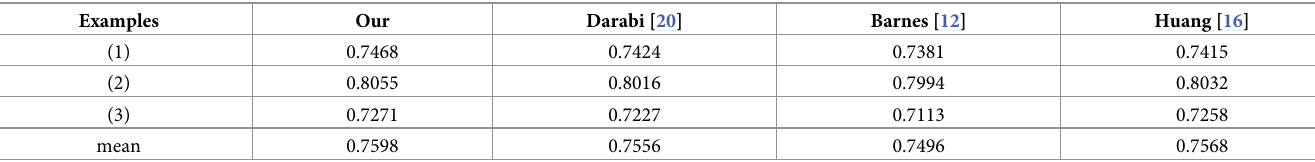
Table 3. Image completion performance of the last three images in Fig 7 measured in